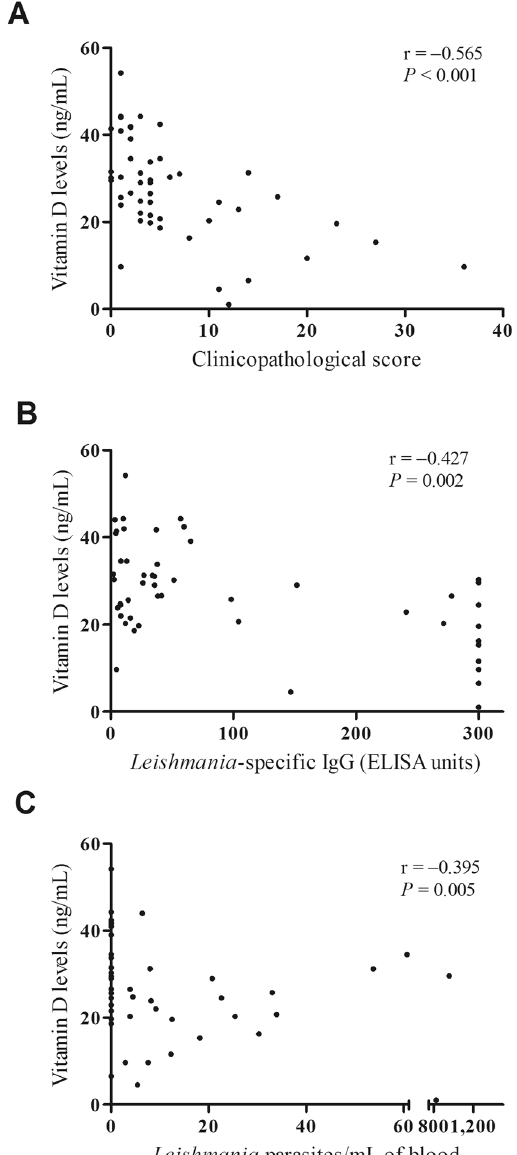
Figure 2. Correlations between vitamin D levels and clinicopathological score ( A ), Leishmania -specifc antibody levels ( B ) and parasite load in blood samples ( C ) from Leishmania -infected dogs. Spearman correlation indexes (r) and P < 0.05 are shown on the graphs.